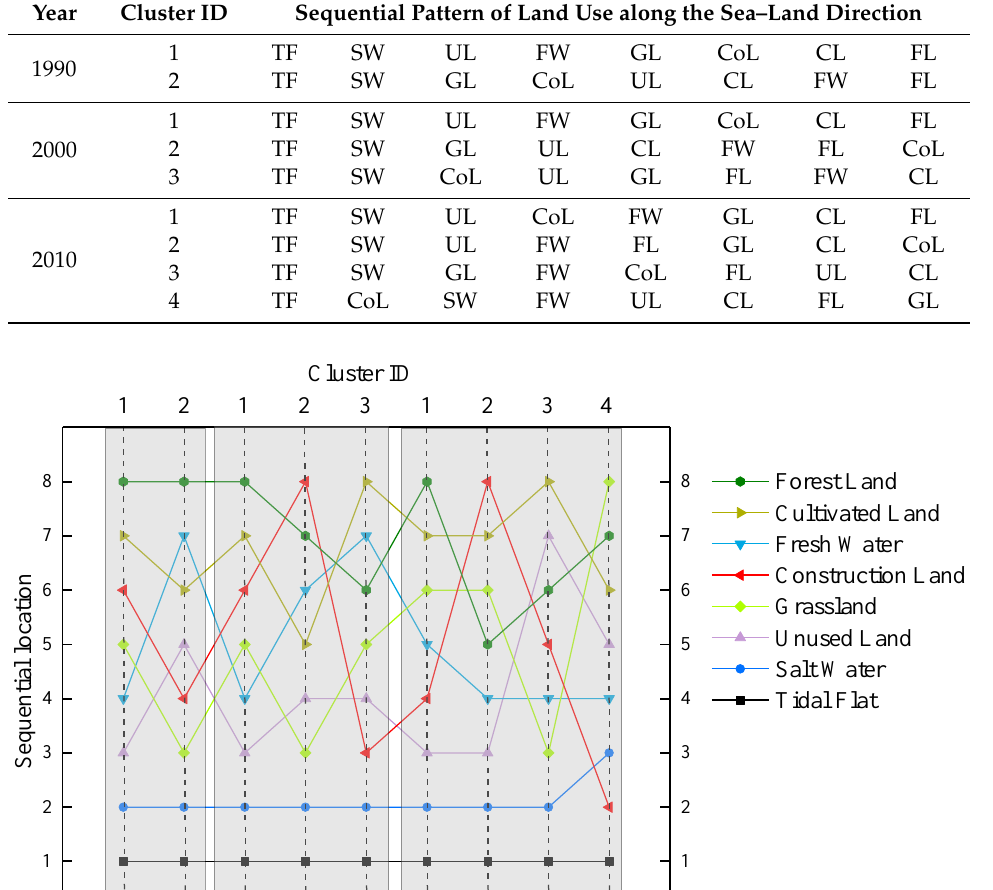
Table 3. CLUSPs from 1990 to 2010.